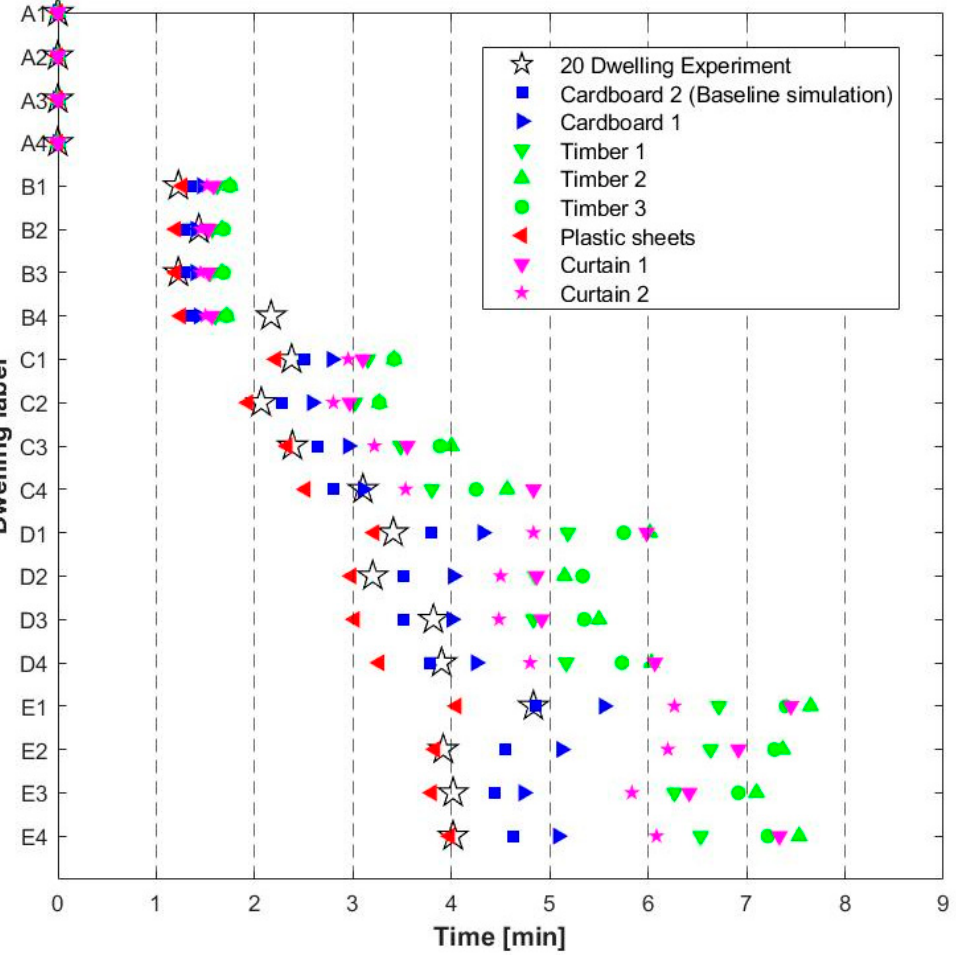
Figure 11. Effect of the B-RISK simulation ignition criteria on the time-to-ignition. Figure 11. E ff ect of the B-RISK simulation ignition criteria on the